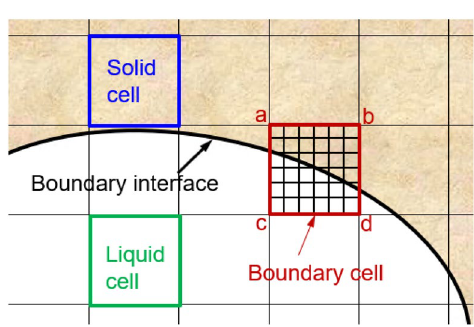
x ) < 0 x ) . φ( N w ( (cid:31) (cid:31) (cid:31)